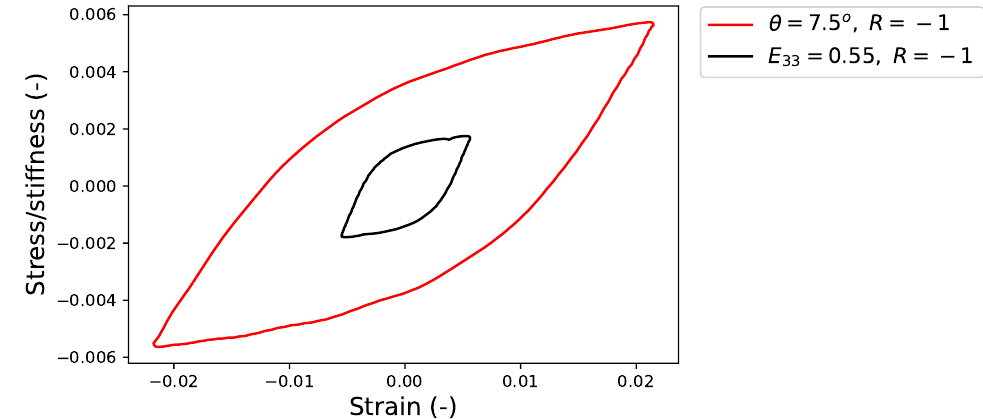
Figure 14. Comparison of the hysteresis loops in the regime where the stress amplitude is constant for the uniaxial fatigue experiment ( E 33 = 0.55%, R = − 1) and the HPTF loading case ( θ = 7.5 ◦ , R = − 1), where θ and E 33 are the amplitudes of the cyclic deformation. The values of all stresses in the plot are normalized with the corresponding stiffness parameters, i.e., Young’s Modulus Y = 185.2 GPa for uniaxial fatigue and shear modulus G = 76.506 GPa for the torsional loading during